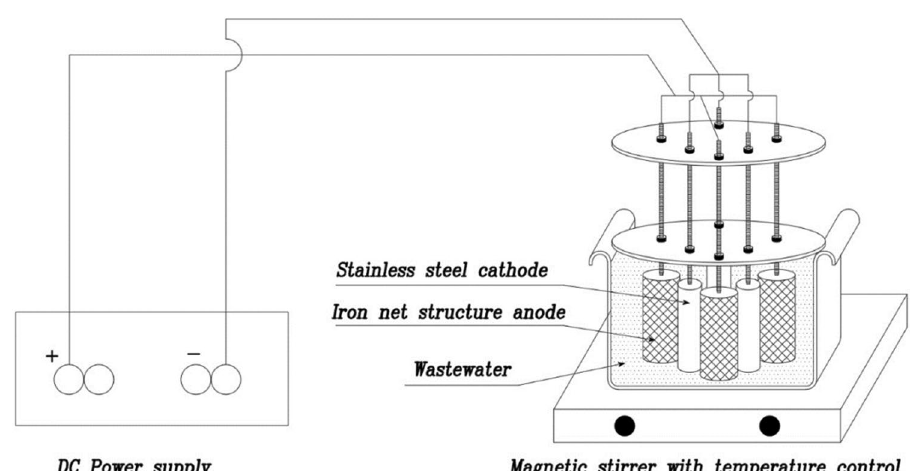
Fig. 2 Schematic representa- tion of the EC